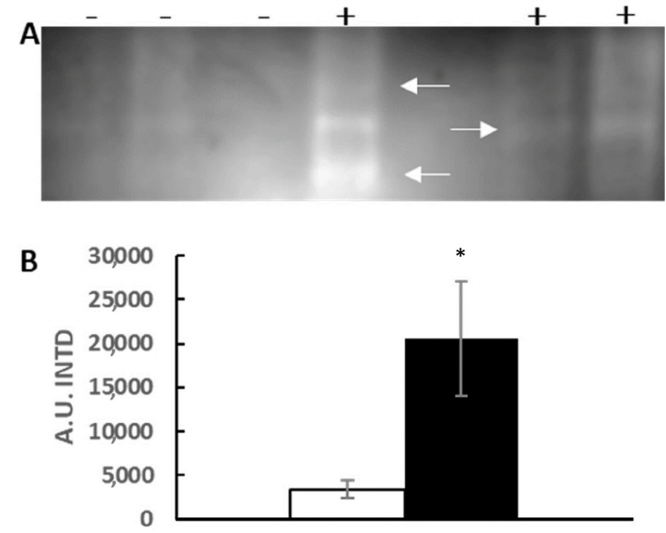
Figure 7. Effect of silver nitrate on total GPX activity in gills. ( A ) Representative native PAGE stained for the in-gel activity of GPX. Arrows show position of the GPX achromatic bands. ( B ) Semiquantitative evaluation of total GPX activity in gill extracts obtained from mussels treated with 20 µ g L − 1 AgNO 3 (black box) vs. control reference (open box). In this analysis, the integrated intensity (INTD) of all visible achromatic bands was considered. * statistically different from control, p < 0.05, two-sample Kruskal–Wallis, n = 12.